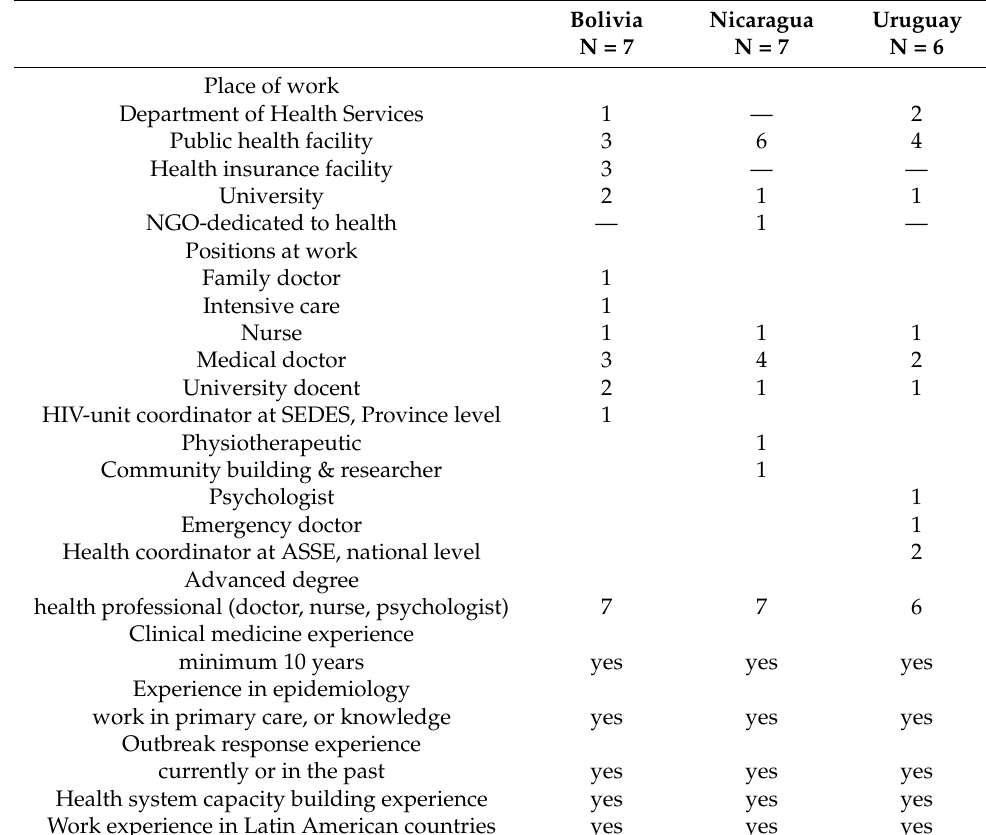
Table A2. Experts’ characteristics in the